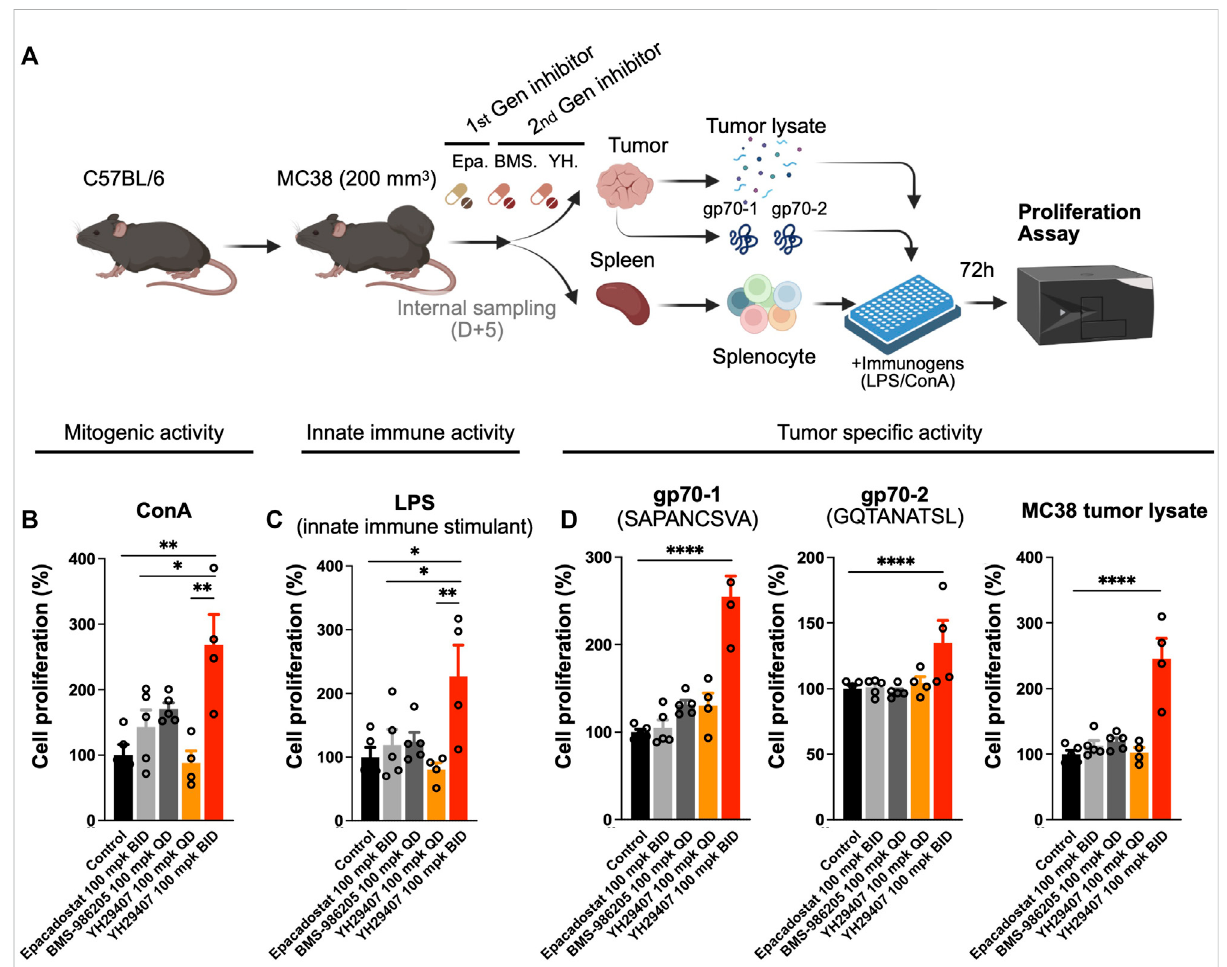
Proliferation of immune cells treatedwith YH29407wassigni fi cantly increased after stimulation with tumor-associated antigen (gp70-1, gp70- 2). (A) MC38 tumor was grafted onto C57BL/6 mice and 5 days of treatment was started after the tumor volume reached 200 mm 3 . Then, splenocytes were obtained and cells were seeded after being counted using a hematocytometer, and the cells were stimulated with MC38 tumor lysate, gp70-1, gp70-2, ConA, and LPS for 72 h. Cell proliferation assay showed T cell (B) and innate immune activation (C) . Moreover, tumor- speci fi c T cells were enriched after stimulation with MC38 tumor lysate and tumor-associated antigen (D) . * p < 0.05, ** p ≤ 0.01, **** p ≤ 0.0001. ConA, concanavalin A; LPS, lipopolysaccharide; IFN- γ +, interferon